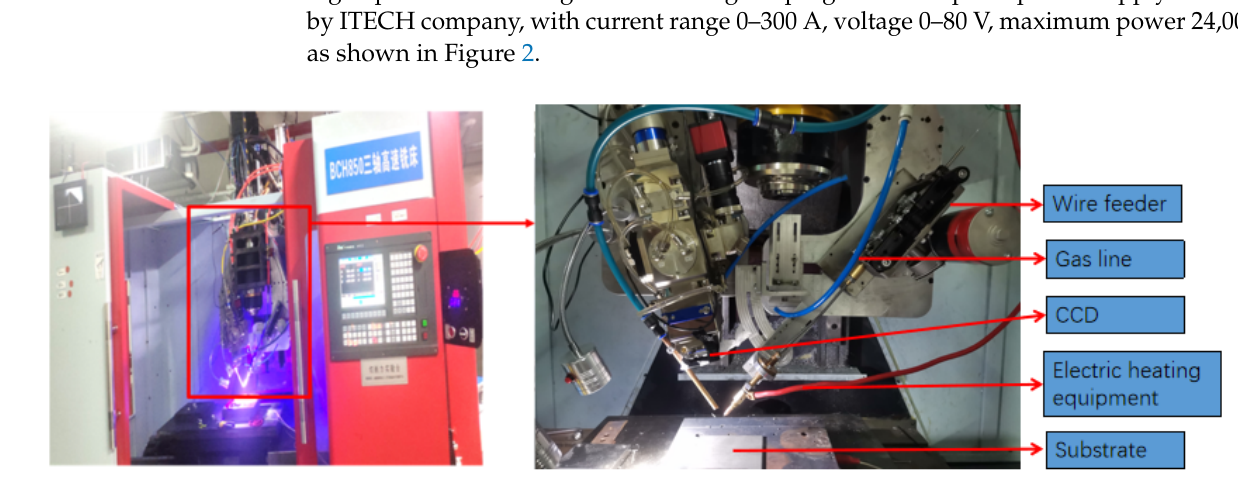
Figure 2. Experimental equipment.